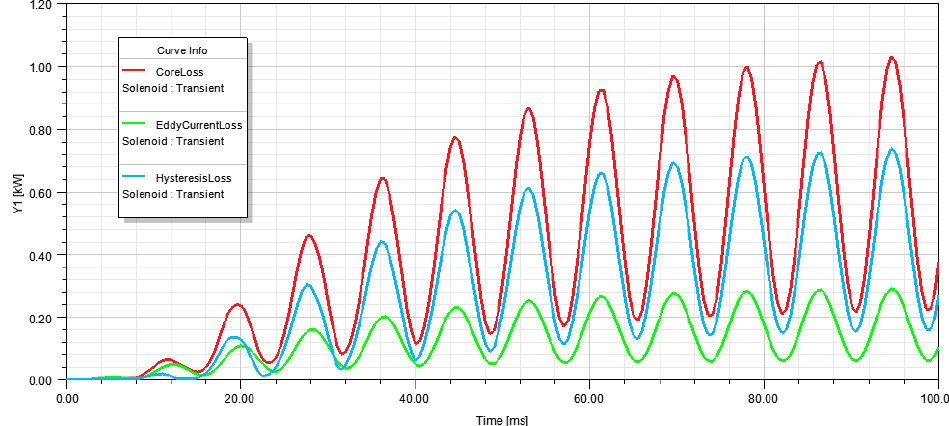
Figure 7. Core losses of standard design transformer.